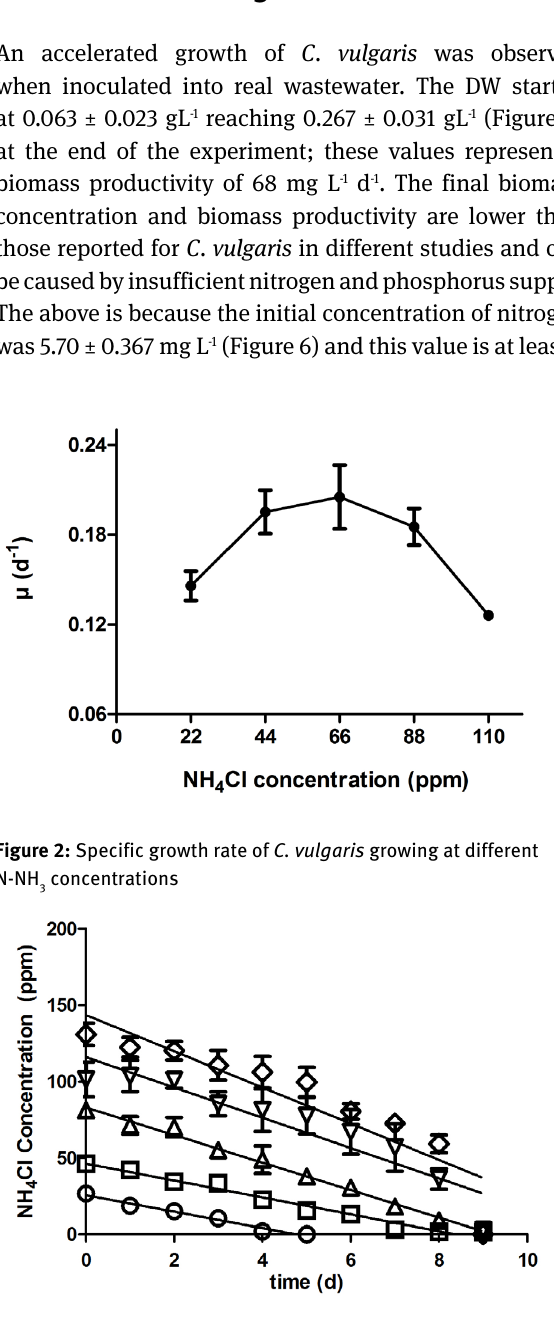
Figure 3: Residual nitrogen concentration in culturing media. (●)